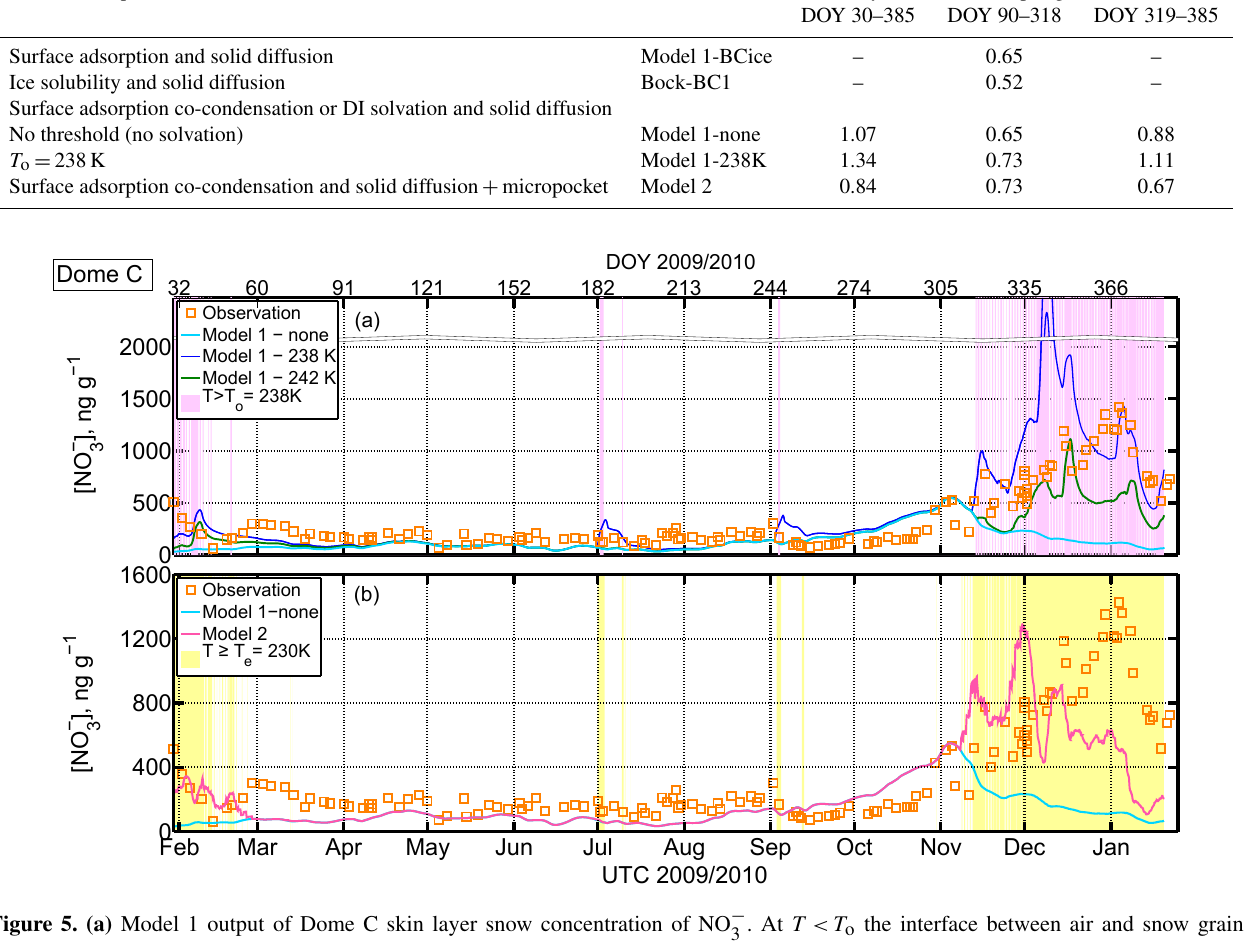
Table 2. Summary of model performance at Dome C based on the coefficient of variation of RMSE, C v (RMSE). Model description